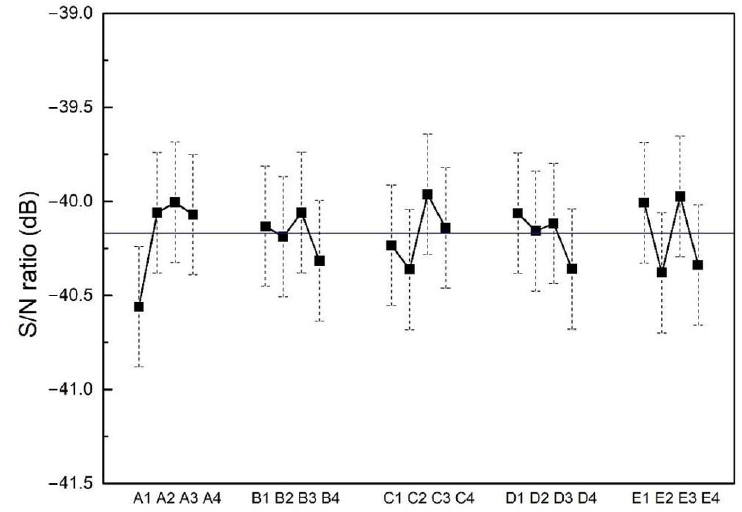
Figure 8. Taguchi analysis plot for film resistivity, where the experimental factors (A, B, C, D and E)